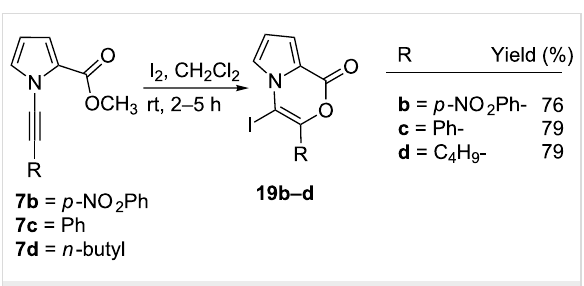
Scheme 5: Electrophilic cyclization reactions of 19a–c with iodine.